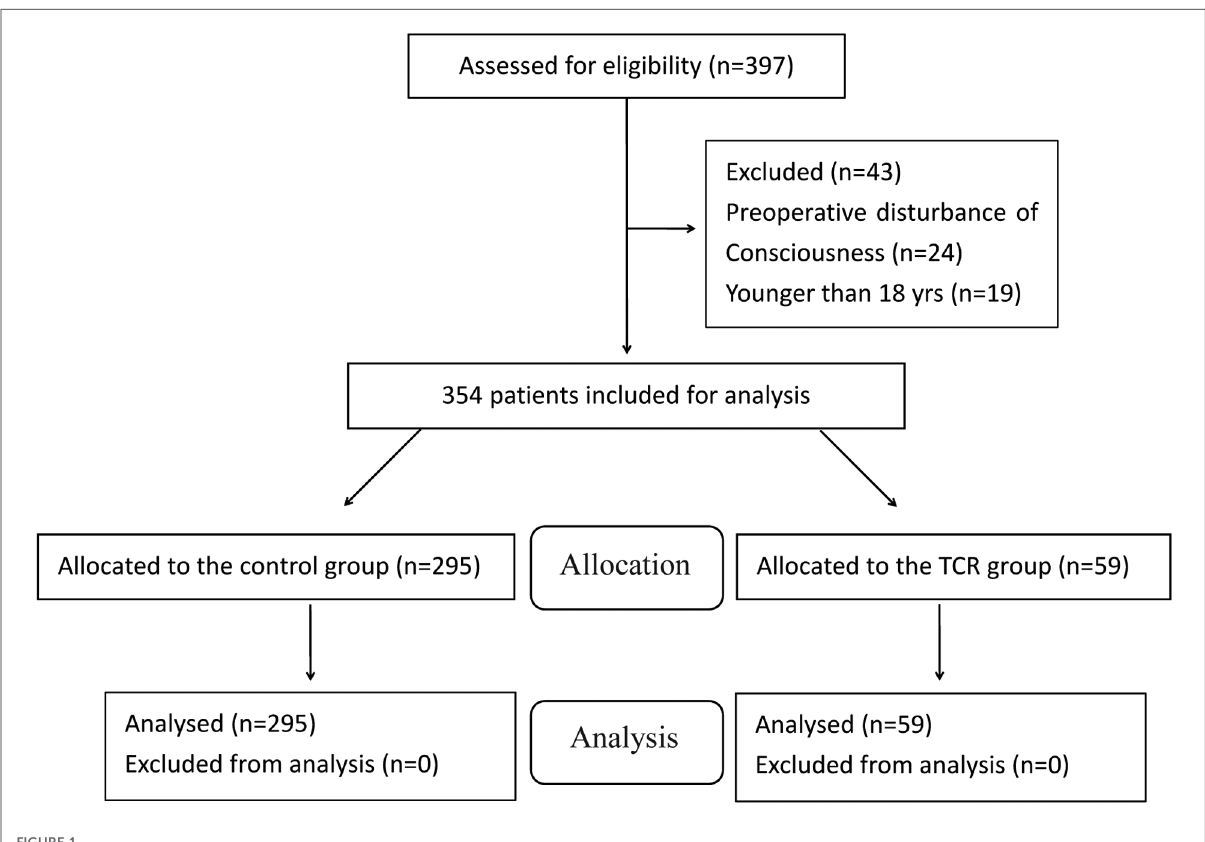
FIGURE 1 Study fl ow